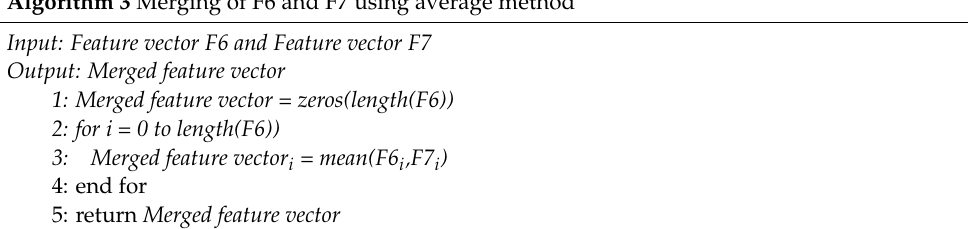
Algorithm 3 Merging of F6 and F7 using average